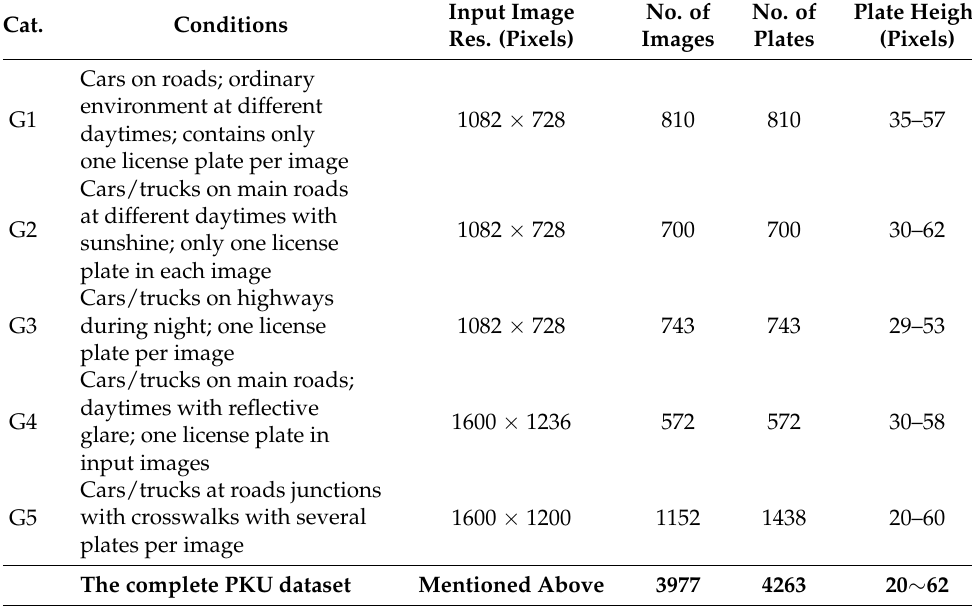
Table 2. Description of the PKU